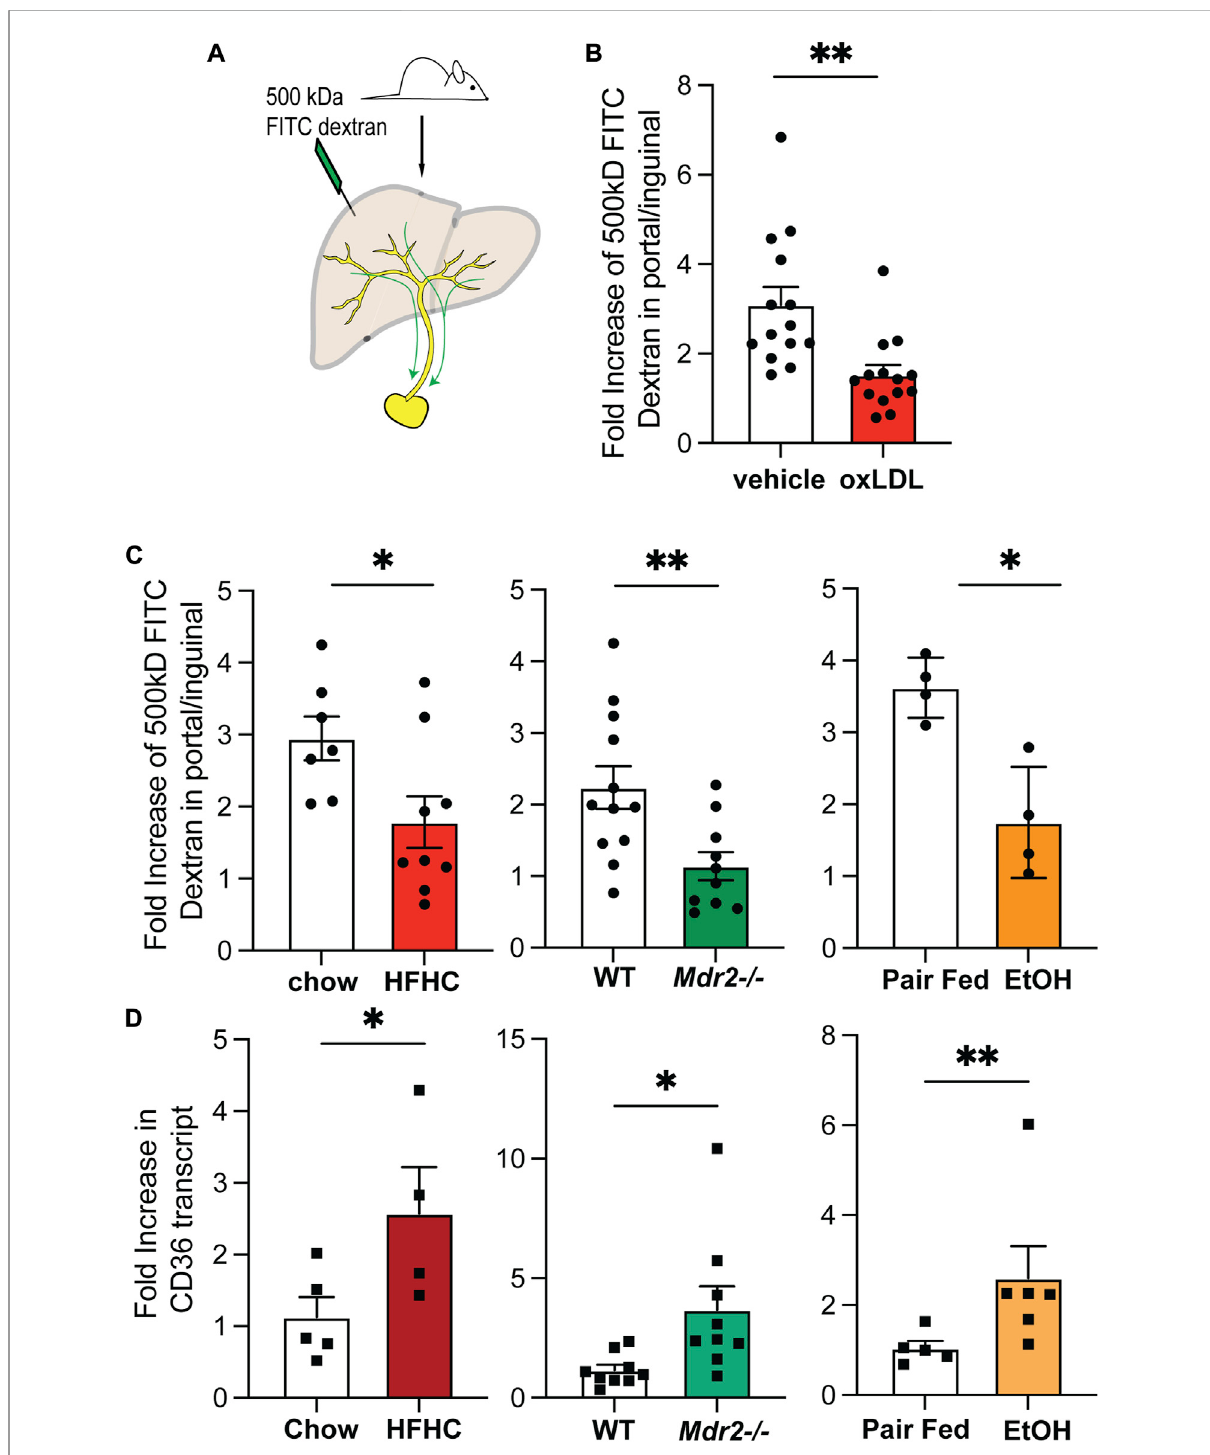
FIGURE 1 Reduced traf fi cking of high molecular weight Dextrans to liver draining lymph nodes of mice with increased oxLDL receptor expression. (A) Mice were anesthetized and abdominal cavity exposed. 10uL of 500 kDa FITC-dextran was injected each into the left, median and right lobes of the liver.Tenminutesafterthelastinjection,theportal(liver-draining)andtheninguinal(skin-draining)lymphnodeswereextracted. (B) Quanti fi cationof FITC in portal compared to inguinal lymph nodes in mice treated with oxLDL (2-week course of 150 ug every other day) as compared to matchedcontrols. Shownare3combinedexperimentswith3-5miceperexperiment. (C) AmountofFITCmeasuredby fl uorescenceintheportalas compared to theinguinal lymph node permouseinmice feda24-weekHFHC (NAFLD model), mdr2 − / − mice (cholestasis model),or Lieber